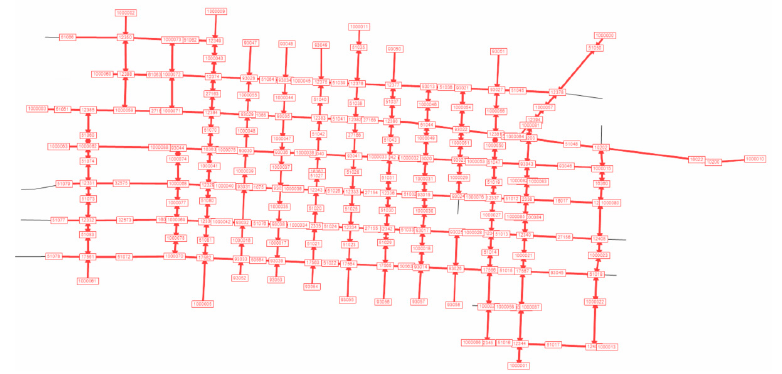
Figure 4. Hillsboro network that was covered by the 450 subpaths.